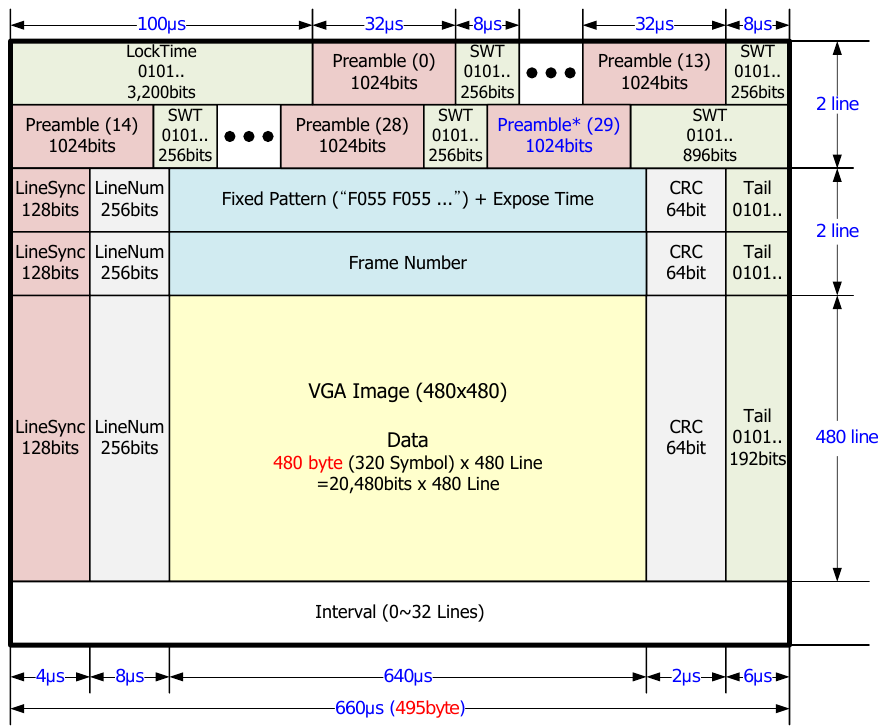
Figure 3. Data frame structure of the CEHBC system.